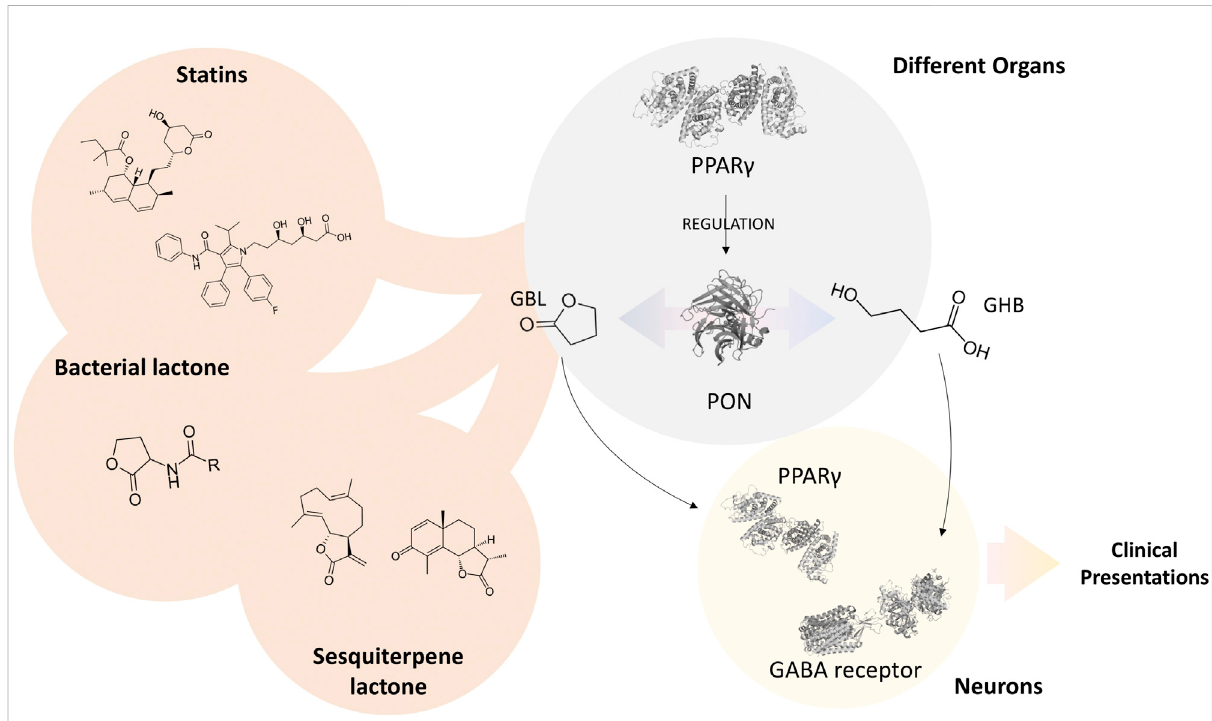
FIGURE 1 Schematic illustration of hypothesis. The three-dimensional illustrations of proteins were obtained from PDBe hosted by EMBL-EBI (https://